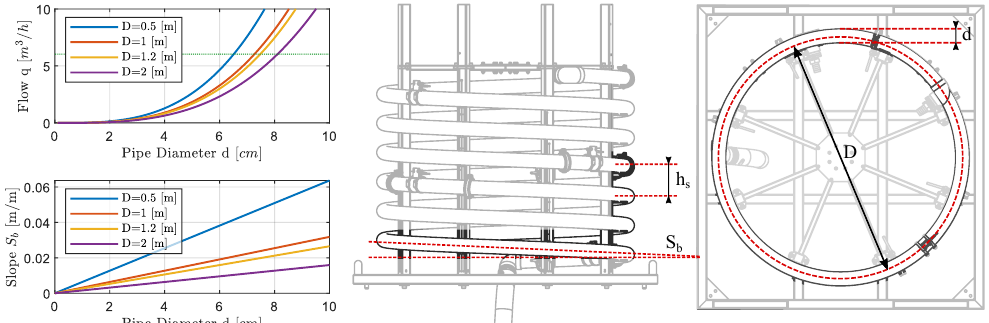
Figure 9. ( Left ): Simulation results of the Manning’s formula with different pipe sizing. ( Center ): Front view of the mechanical drawing of the gravity sewer. ( Right ): Top view of the mechanical drawing of the gravity sewer.